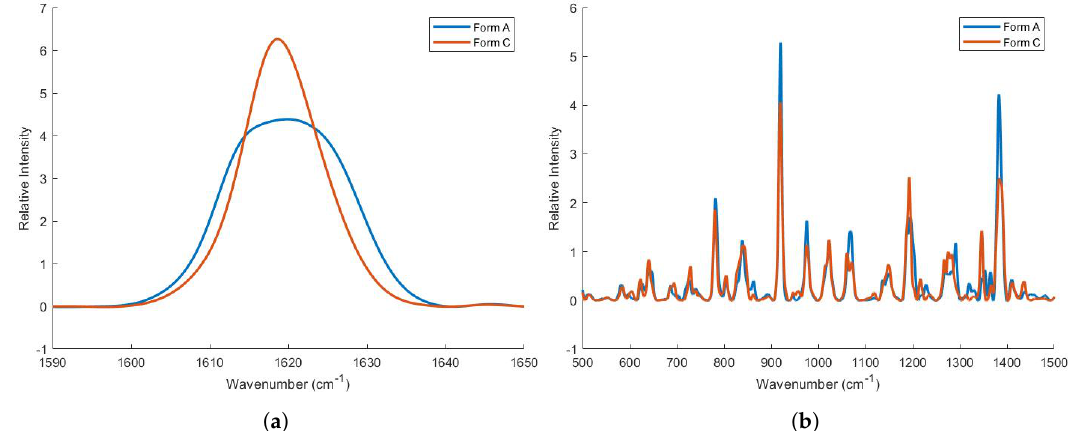
Figure 4. Differences in the Raman spectra of two polymorphs of zolpidem hemitartrate (form A and form C). ( a ) The intense band representing the C=O stretching of the amide showed band broadening in the hydrate crystal (form A) due to hydrogen bonding. ( b ) Both spectra are fairly divergent, which indicates a distinct re-arrangement within the molecule upon